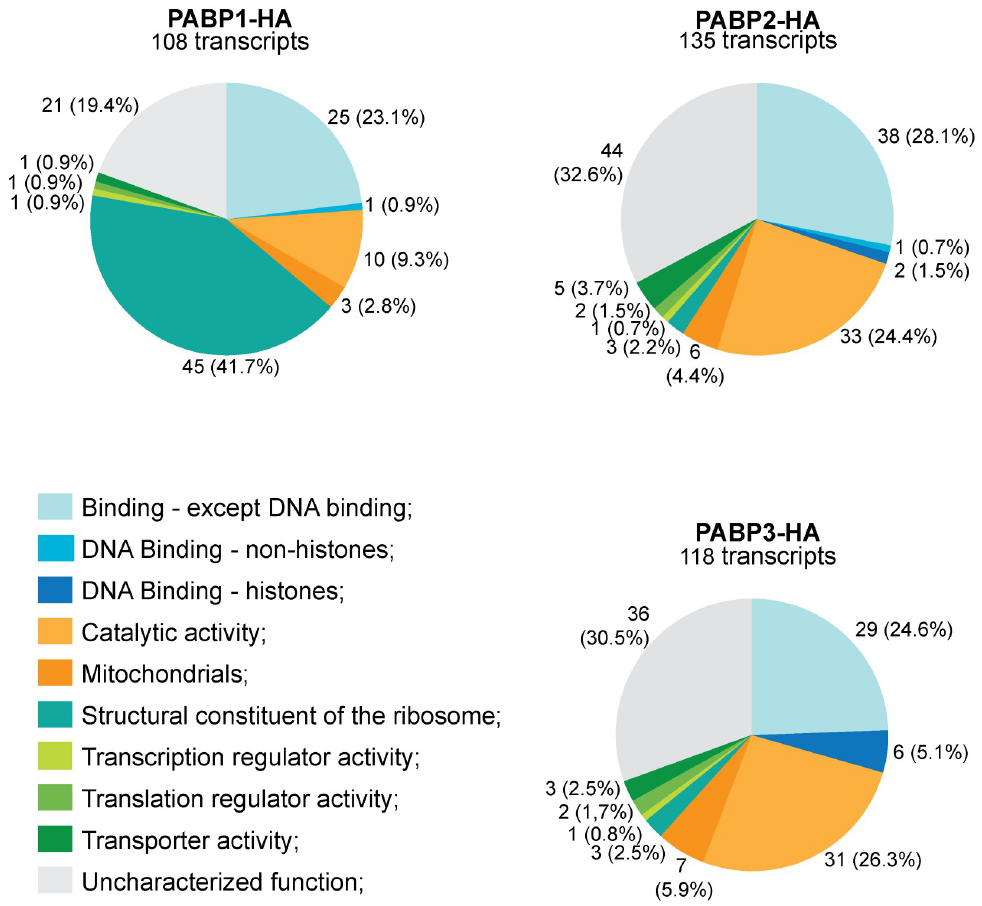
Fig 1. Analysis of mRNA populations associated with the three HA-tagged Leishmania infantum PABPs. mRNA groups associated with the recombinant HA-tagged PABP1, PABP2 and PABP3 from L . infantum (Illumina sequencing). Enriched genes in at least two of three available RNA-seq datasets were manually classified and grouped using the gene ontology (GO) terms according to their molecular function. ‘Enriched’ means at least 2-fold more abundant than in the negative